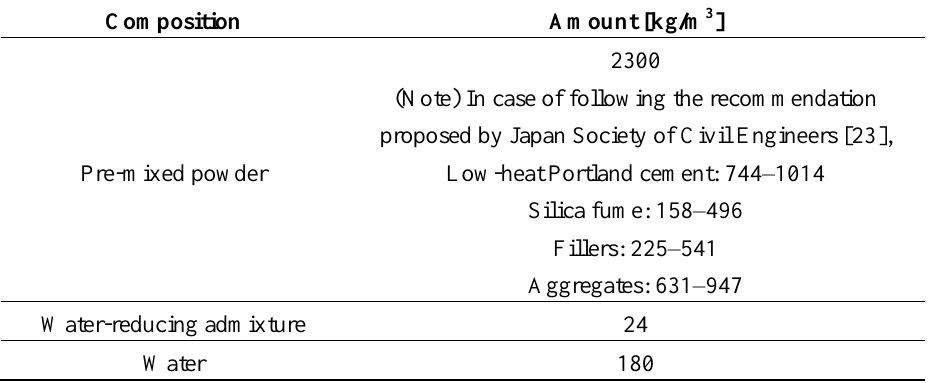
Table 1. Composition of high-strength and ultra-low-permeability concrete (HSULPC).